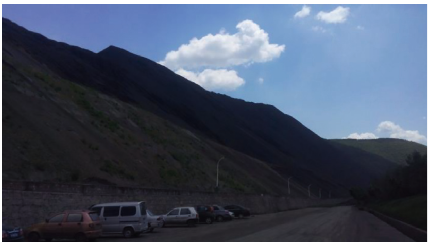
Figure 1: A landfill site of abandoned oil shale semicoke in Jilin province of